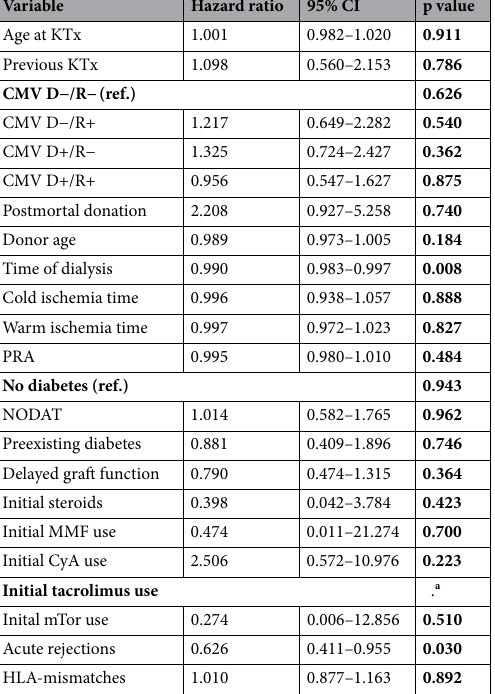
Table 4. Cox regression for BKPyV DNAemia risk factors. KTx kidney transplantation, CMV cytomegalovirus, D/R donor/recipient, PRA panel reactive antibodies, NODAT New onset diabetes after transplantation, MMF mycophenolate mofetil, CyA cyclosporine A, mTOR mechanistic target of rapamycin, HLA human leukocyte antigen. Bold: p-values. a Degree of freedom reduced because of constant or linearly dependent